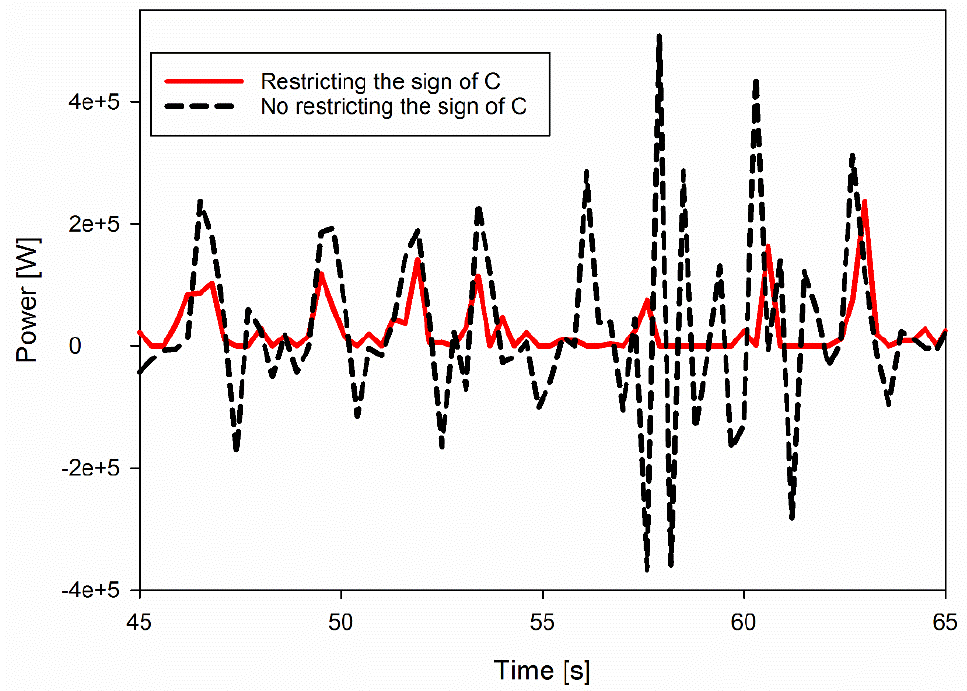
Figure 6. Instantaneous power of the WEC under NPC with or without restricting the sign of (cid:1829) . (cid:1848) = 2.0 m/s, (cid:1852) = 1.5 m. (cid:1834) = 2.0 m, (cid:1846) = 5.24 (cid:2923)(cid:2911)(cid:2934) (cid:2923)(cid:2911)(cid:2934) (cid:3046) (cid:3043)